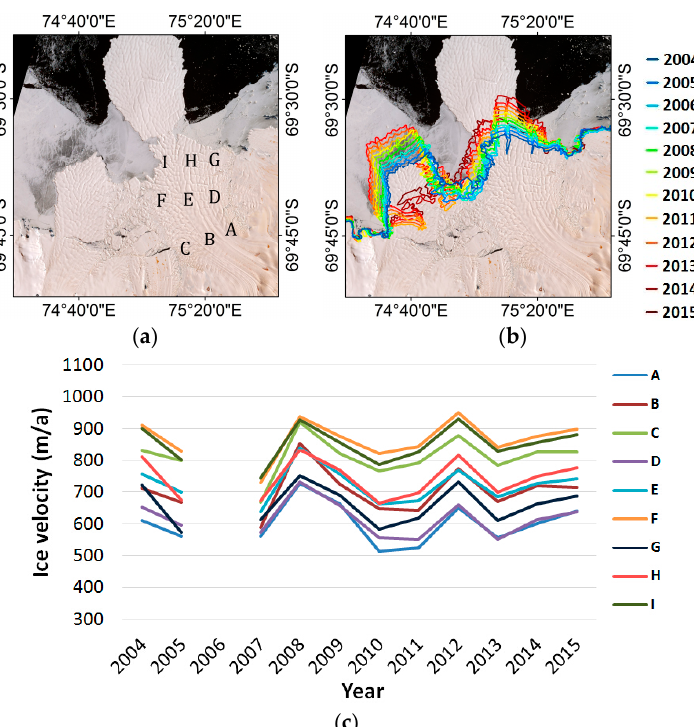
Figure 11. Annual frontal margins and multi-temporal ice velocities of the PRG. ( a ) Nine uniformly distributed points named “A” to “I” were chosen on the PRG for further analysis; ( b ) Annual frontal margins from 2004 to 2015 shown in different colors; ( c ) Annual ice velocities of different points from 2004 to 2015.